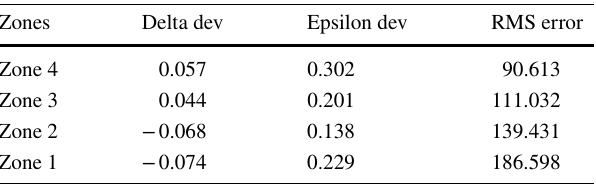
Table 2 Anisotropic values extracted along the well in different zones using the exact solution